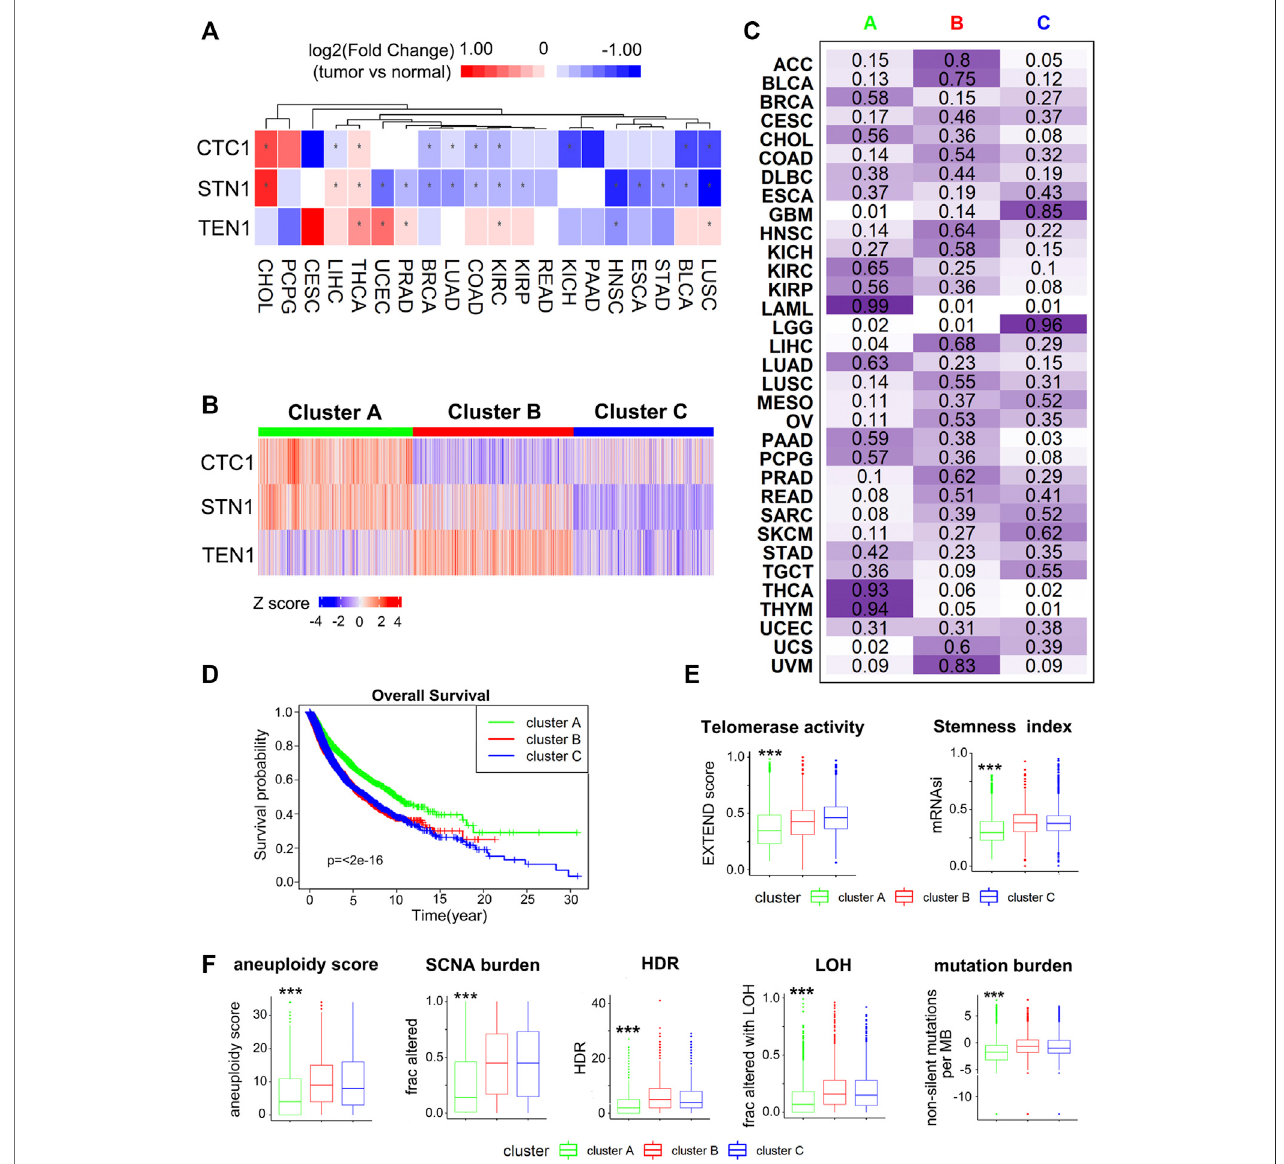
FIGURE 2 | Expression landscape of the CST complex: (A) differential expression of CST between the tumor and adjacent normal tissue for 20 cancer types that have more than three adjacent normal samples. In the heatmap, red indicates high expression in the tumor, and blue indicates low expression, * p < 0.05. (B) UnsupervisedclusteringofCST geneexpressionrevealsthreedistinct clustersmarkedbyadifferentcolorinthetopbox. Eachrow represents agene, andeach column is a patient. Red indicates high expression, and blue indicates low expression. The expression data were normalized by z-score normalization for each row. Unsupervised clustering used k-means clustering. (C) Sample distribution in the three clusters. Each row represents a cancer type, and each column represents a cluster. The number and the color intensity in each box show the percentage of samples classi fi ed in the corresponding cluster. (D) Kaplan – Meier curves of overall survival in three clusters. Statistical analysis was performed using the log-rank test. (E) Boxplots show the telomerase activity (left) and stemness index (right) in three clusters. (F) Boxplots display the levels of a list of genome instability scores among the three clusters, including aneuploidy score, SCNA burden, HRD, homologous recombination de fi ciency, LOH, loss of heterozygosity, and mutation burden. The differences among three clusters were tested by the Wilcoxon test, *** p < 0.001.